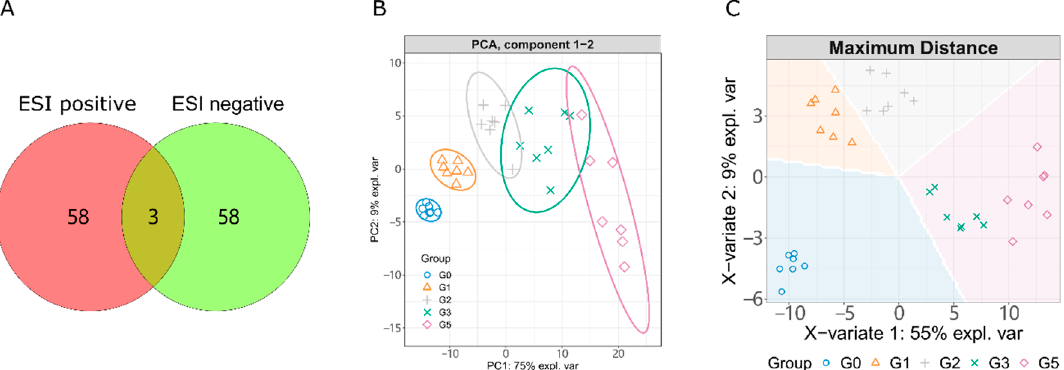
Figure 2. ( A ) Numbers of metabolites identified by positive and negative UPLC-ESI-MS. PCA ( B ) and sPLS-DA ( C ) analysis of LC-MS profiles of metabolism. The colored background represents predicted classes.